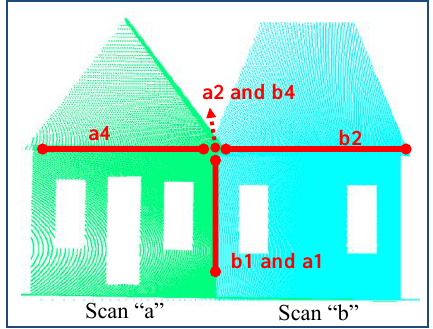
Figure 8. An example of false compatibility match using non- conjugate linear